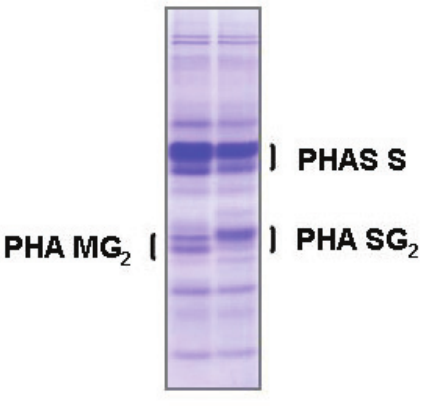
Figure 3. Electrophoretic patterns of phaseolin (PHAS) and phytohemagglitinin (PHA) in seeds of ‘Fagiolo del Purgatorio’ from Gradoli